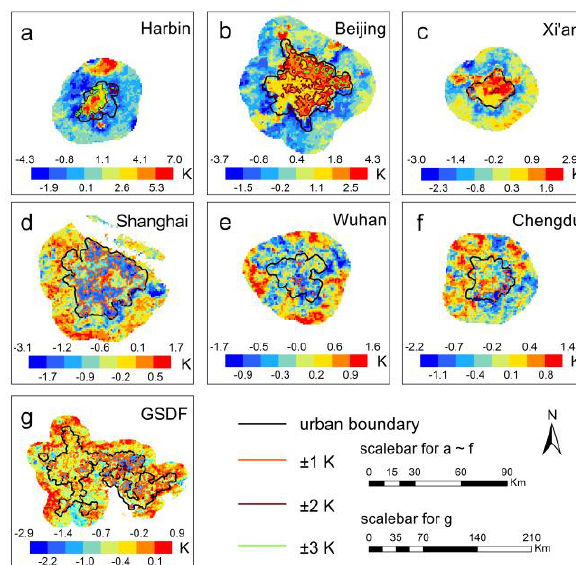
Figure 3. Spatial distributions of the annual mean daytime ∆SUHII within the chosen seven cities. Urban areas (within the black lines) and rural areas within a 15-km buffer zone are shown for each